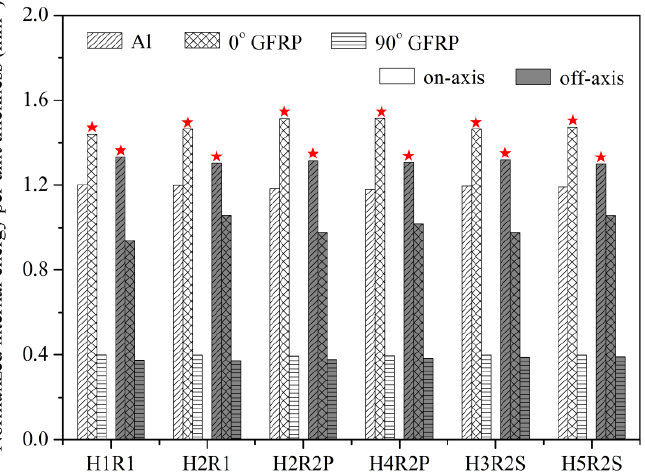
Figure 15. Normalized internal energy per unit thickness in constituents of Glare with different hole arrangements.